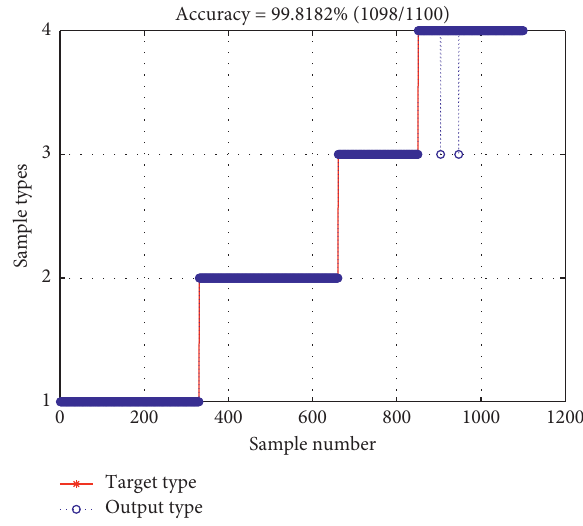
Figure 16: Recognition rate of SVM on SV features. Table 5: Recognition rate of SVM on different